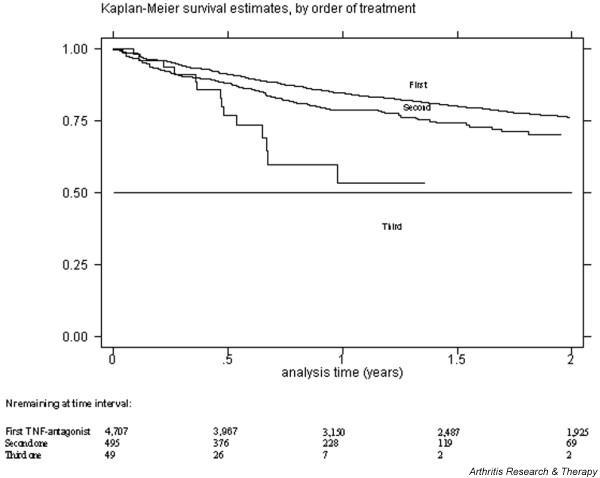
Survival curve of tumor necrosis factor (TNF) antagonists in BIOBADASER during the first two years of use, ranked by order of treatment. The numbers under the curves represent the patients known to be still on treatment by the end of the interval. Differences in the number between intervals do not mean that patients failed (stopped TNF antagonist). They actually represent the patients known to be still on treatment as of the time marked.